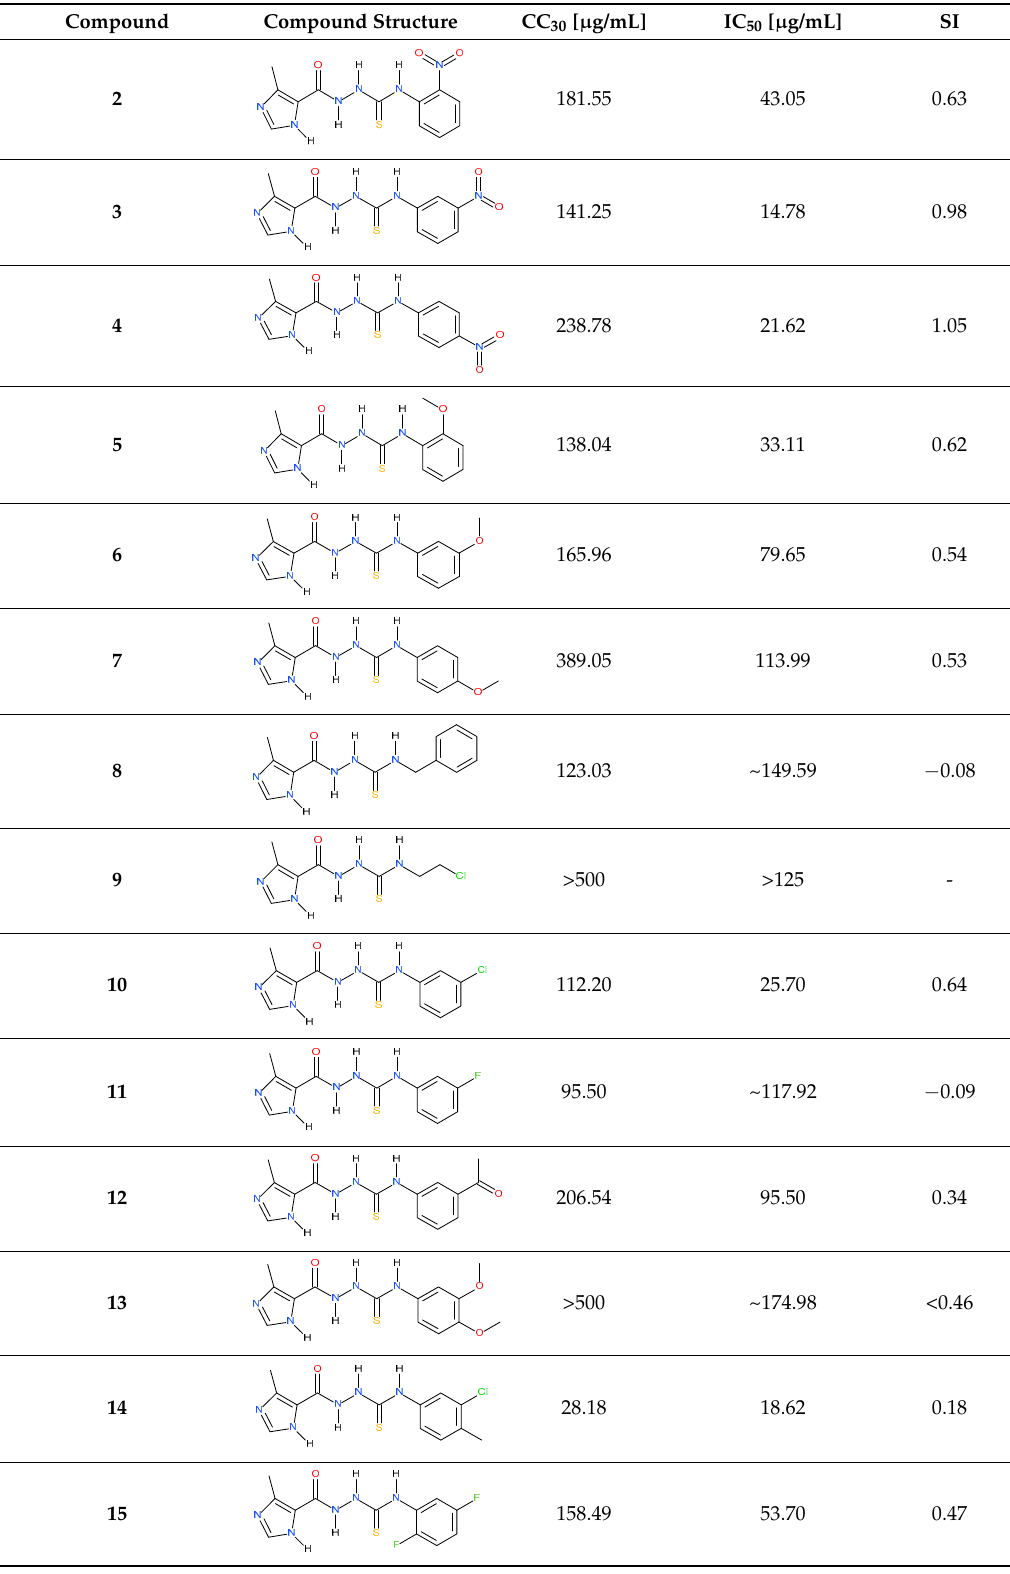
Table 3. Presentation of CC 30 , IC 50 , SI values and compound structures of derivatives 2 – 22 and sulfadiazine.